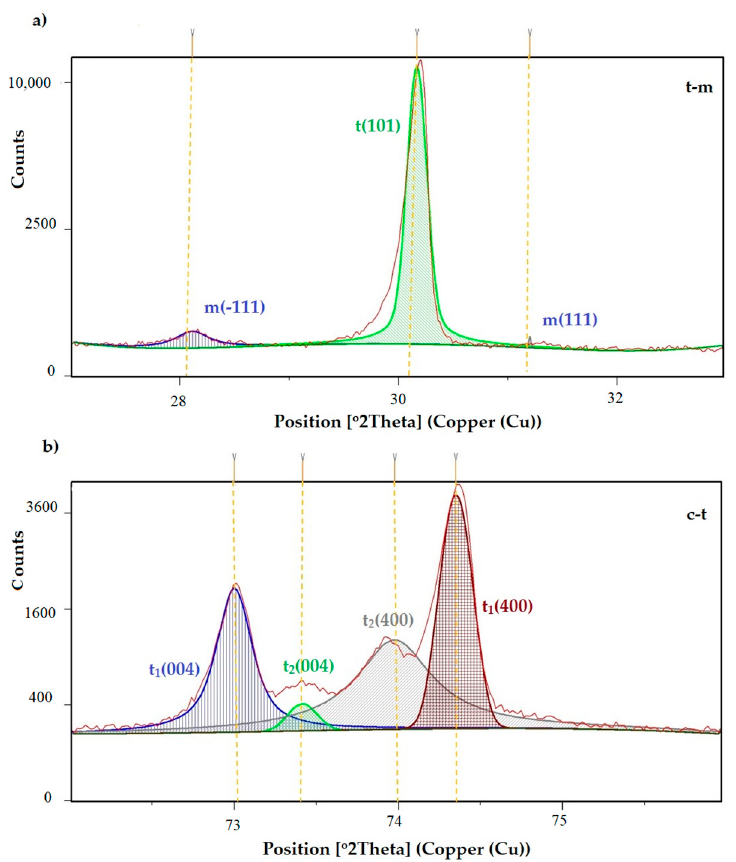
Figure 5. ( a ) t-m, ( b ) c-t transformation of the crown B4_in_chsx2_50N.